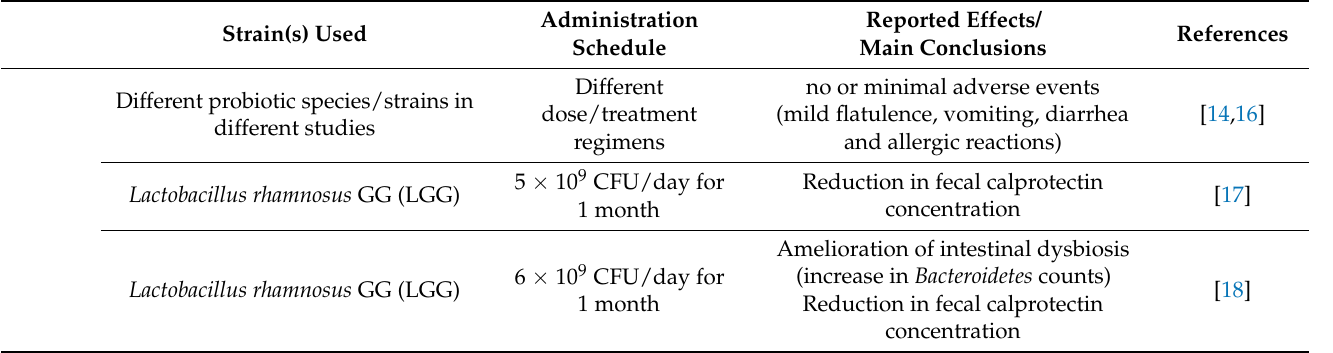
Table 1. Opportunities and challenges of the oral administration of probiotics in